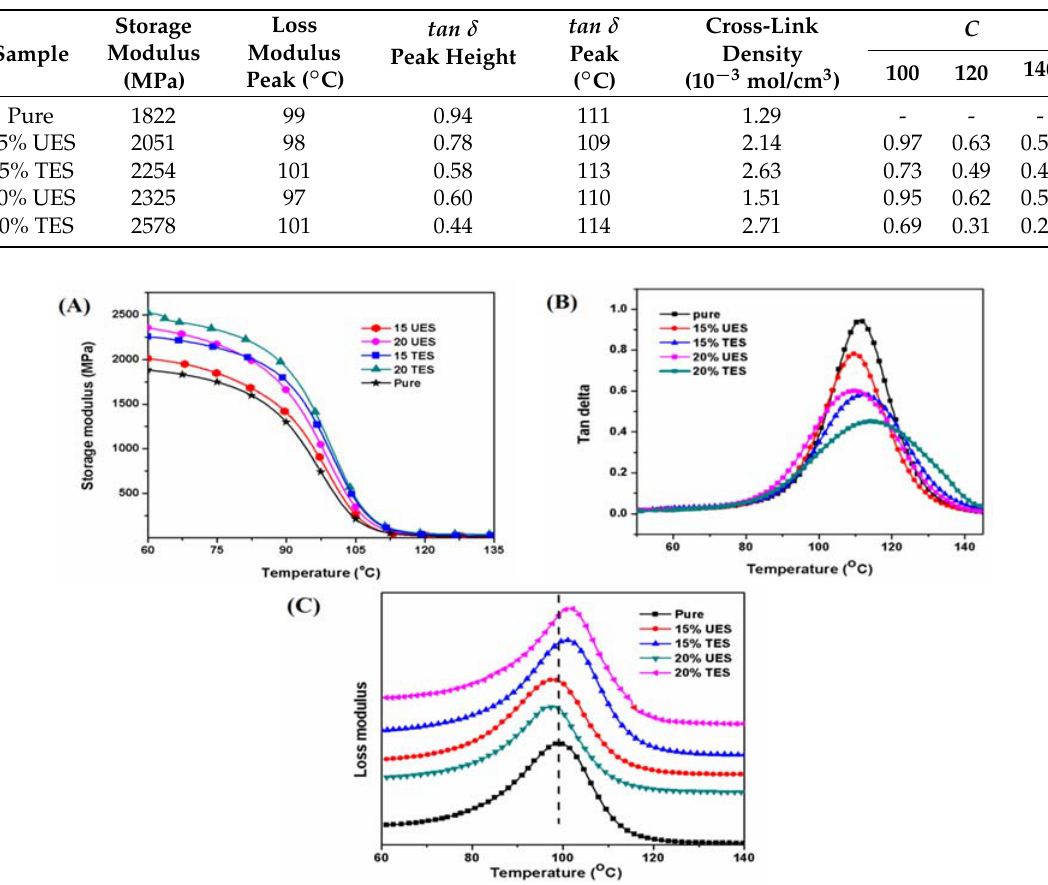
Figure 8. Storage modulus ( A ), tan δ ( B ) and loss modulus ( C ) of pure epoxy, UES and TES filled epoxy composites.